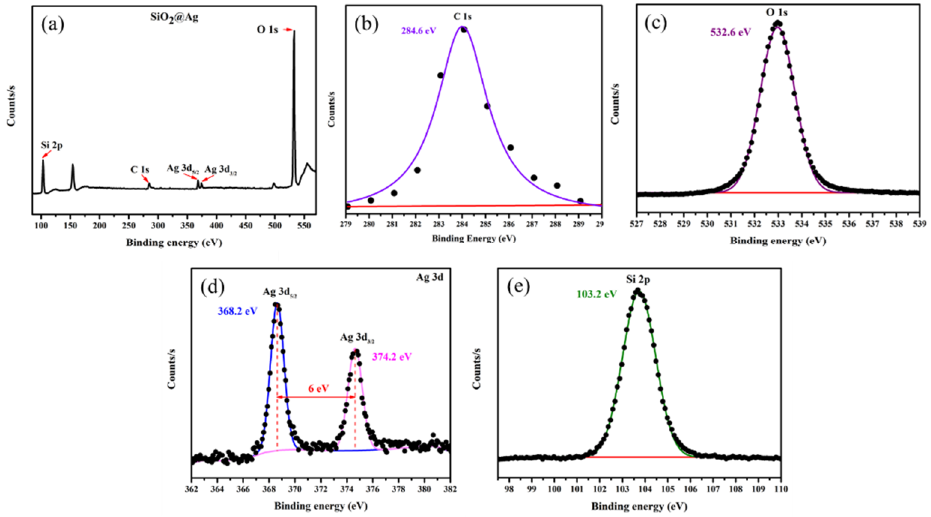
Figure 3. The XPS measurement of SiO 2 @Ag mesoporous NPs: ( a ) Survey spectrum; ( b ) C1s; ( c ) O 1s; ( d ) Ag 3d; ( e ) Si2p